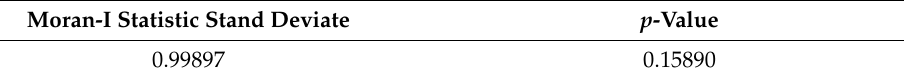
Table 6. Moran’s I test under normality spatial GAM.